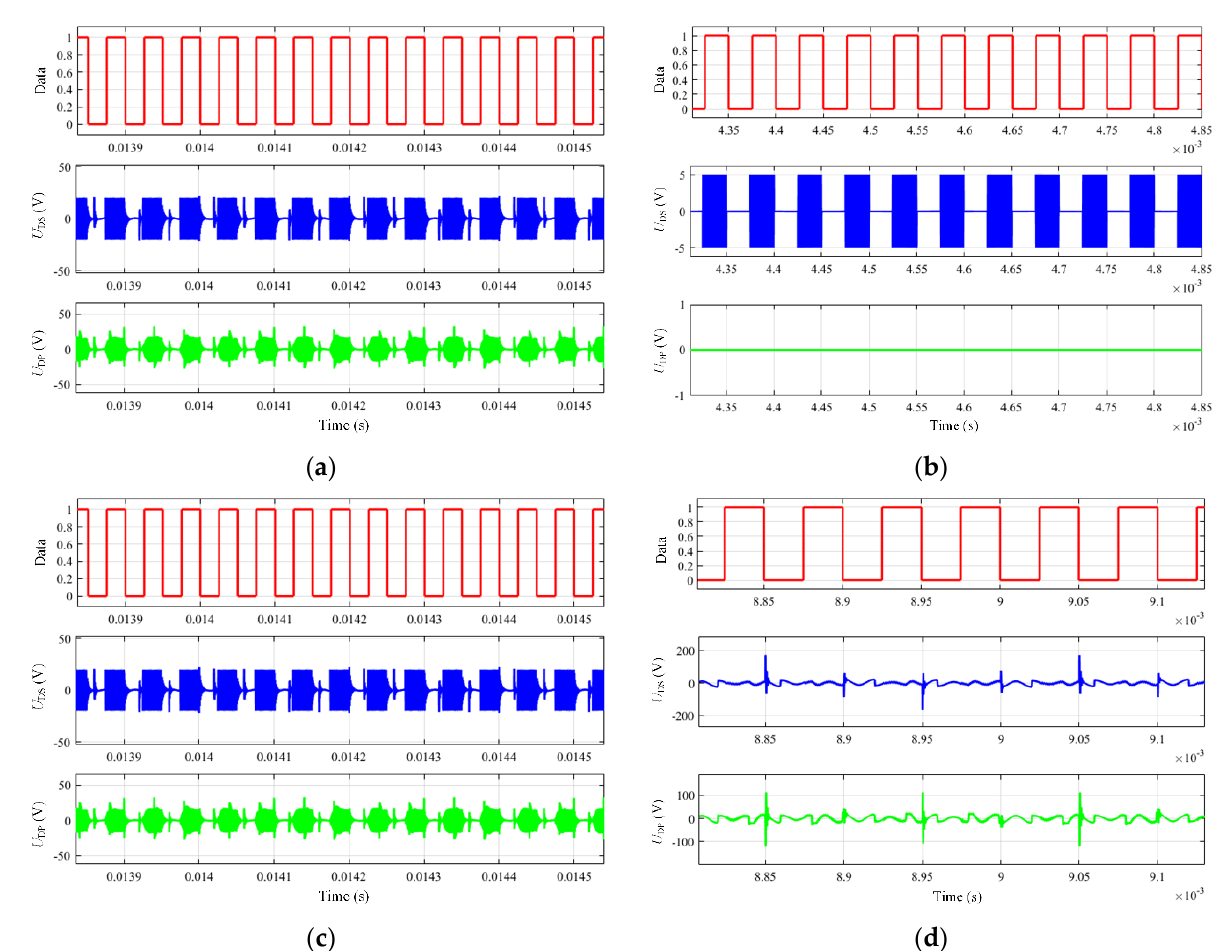
Figure 5. The simulation results: ( a ) With parallel resonance ( L PP , C P2 , L SS , C S2 ); ( b ) without parallel